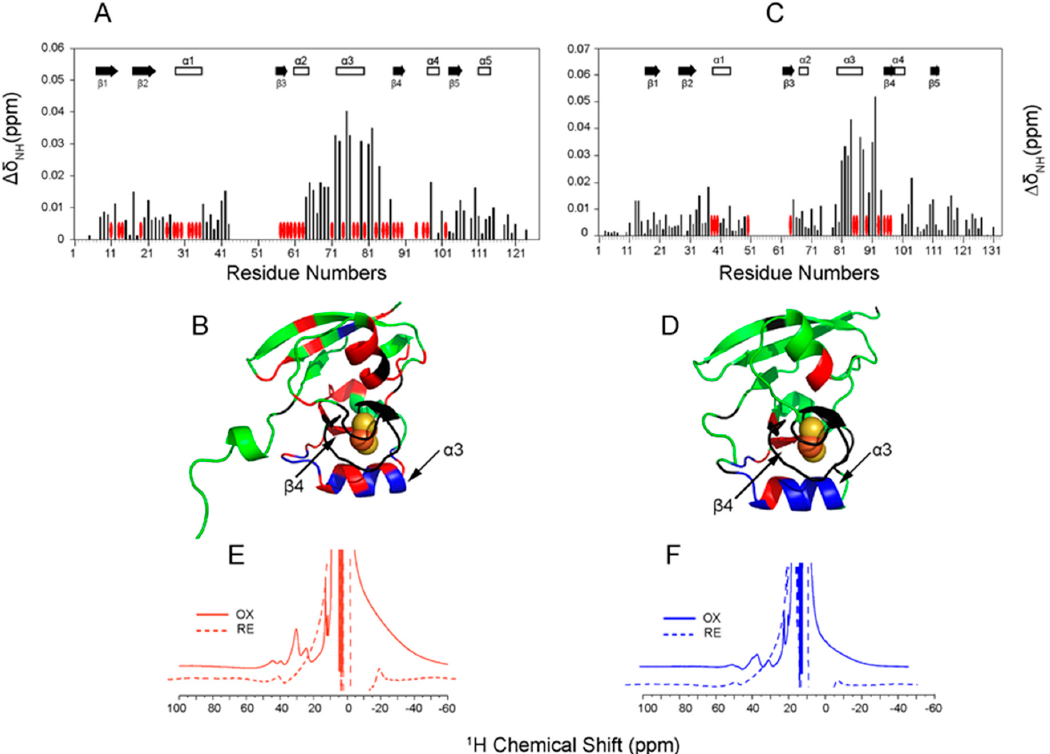
Figure 4. NMR studies of human mitochondrial ferredoxins FDX1 and FDX2 and their interactions with (NIA) 2 . ( A ) Chemical shift (CS) perturbation of the 1 H- 15 N signals ( ∆ δ NH ) of [U- 15 N]-FDX1 resulting from the interaction with (NIA) 2 . The red ovals denote the residues whose signals were broadened beyond detection; ( B ) CS perturbation results from ( A ) mapped onto the structure of FDX1 (PDB: 3P1M). Color code: green, not significantly affected ( ∆ δ NH < 0.03 ppm); blue, significant chemical shift changes ( ∆ δ NH > 0.03 ppm); red, severe line broadening; black, no assignments; ( C ) Chemical shift (CS) perturbation of the 1 H- 15 N signals ( ∆ δ NH ) of [U- 15 N]-FDX2 resulting from the interaction with (NIA) 2 . The red ovals denote the residues whose signals were broadened beyond detection; ( D ) CS perturbation results from ( C ) mapped onto the structure of FDX1 (PDB: 2Y5C). Color code: green, not significantly affected ( ∆ δ NH < 0.03 ppm); blue, significant chemical shift changes ( ∆ δ NH > 0.03 ppm); red, severe line broadening; black, no assignments; ( E ) 1D 1 H-NMR spectra of oxidized (OX) and reduced (RE) FDX1 showing hyperfine shifted signals in the 10 ppm to 50 ppm and − 10 ppm to − 25 ppm regions. ( F ) 1D 1 H-NMR spectra of oxidized (OX) and reduced (RE) FDX2 showing hyperfine shifted signals in the from 10 ppm to 50 ppm and from − 10 ppm to − 25 ppm regions. Adapted from Ref. [137] with